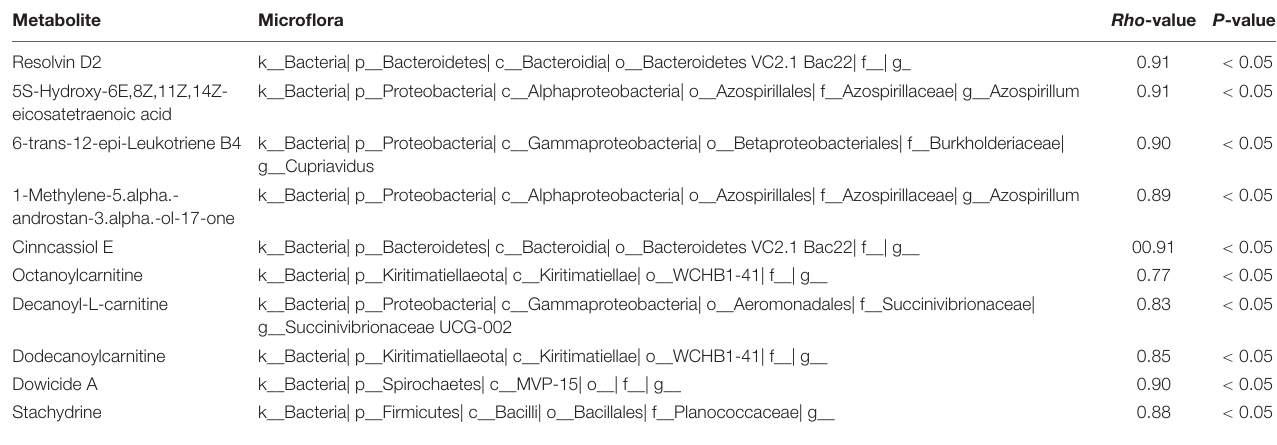
TABLE 3 | The correlation of the differential metabolites and differential gut microbiota.